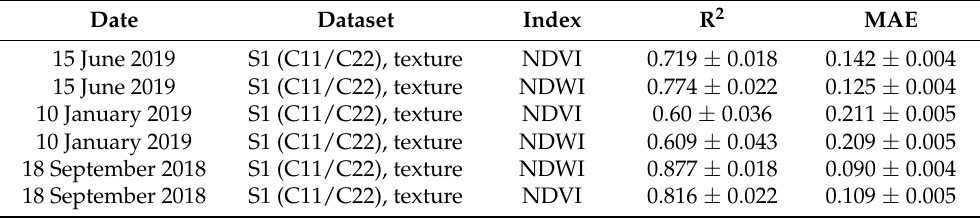
Table 3. Variation in RF-based predicted NDVI and NDWI accuracy based on the different seasons of